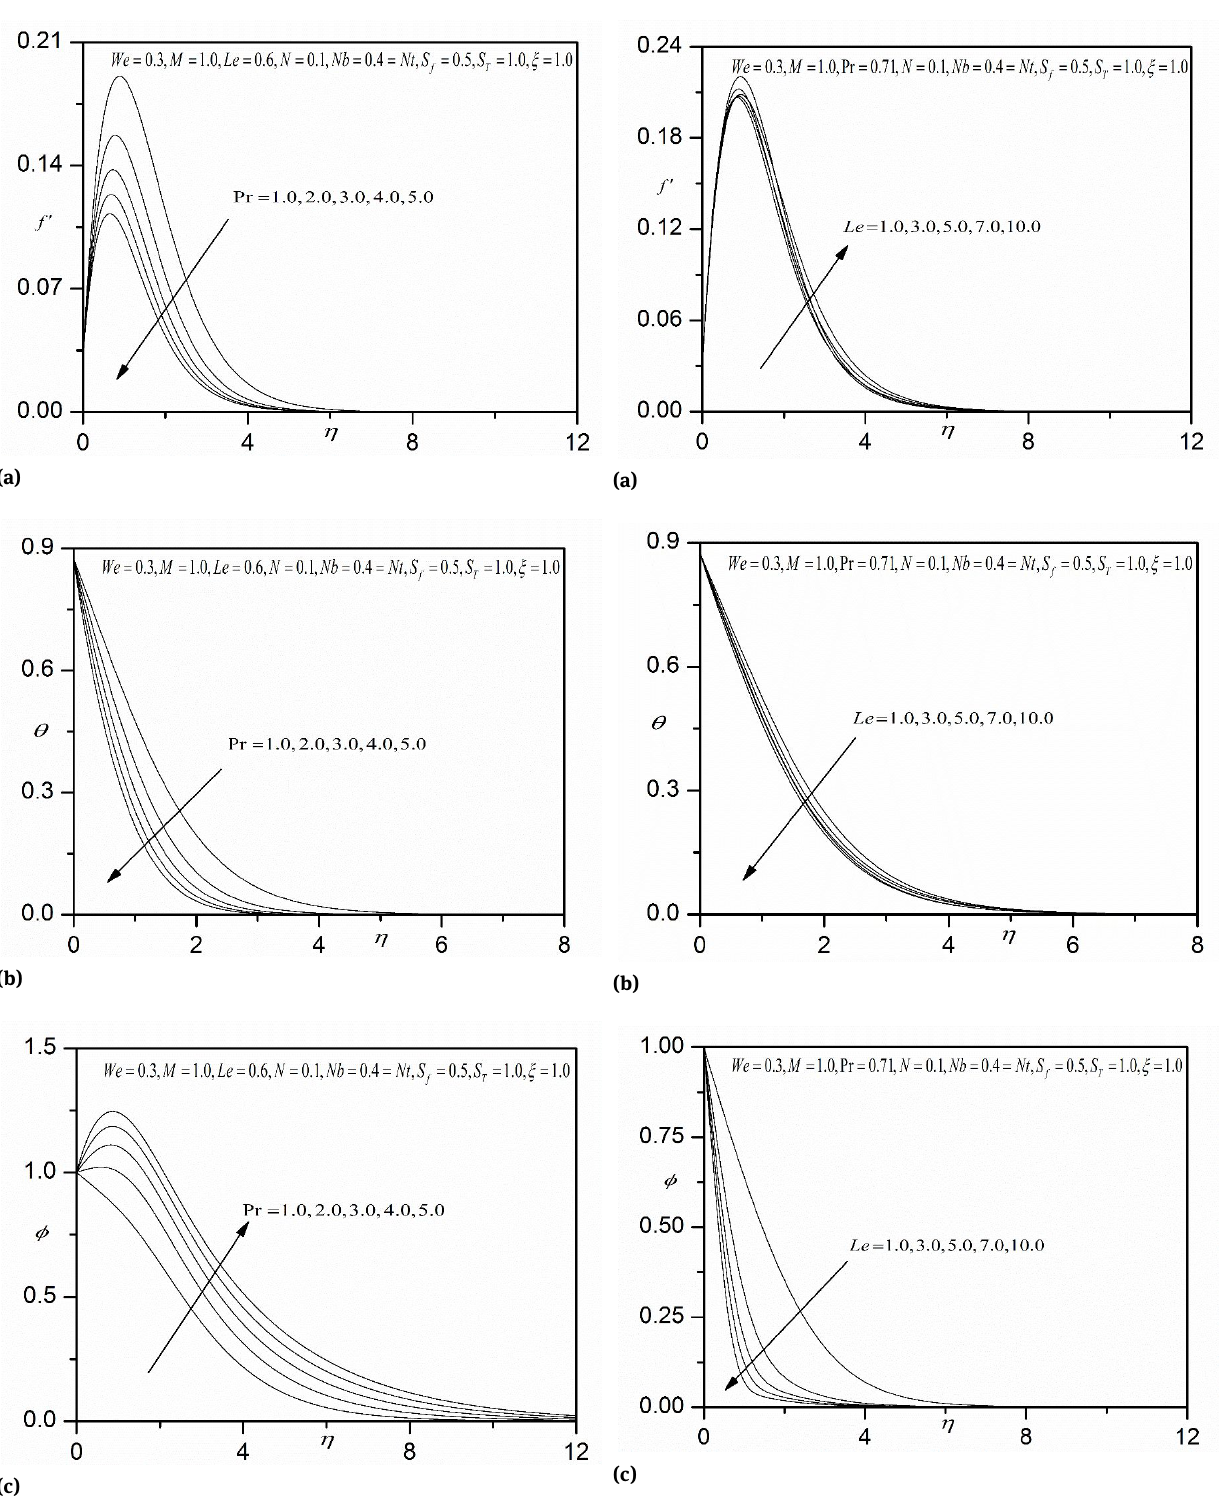
Fig. 9: (a) Effect of Le on velocity profile; (b) Effect of Le on tempera- ture profile; (c) Effect of Le on concentration